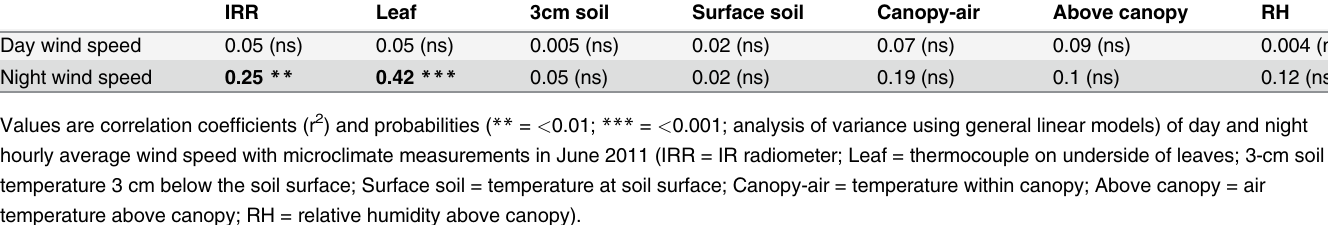
significant tank rental fees). Fig. 4 shows power consumption for one PHACE plot for summer and winter solstice of 2011. Power required to maintain the set temperatures varied greatly during single day and night periods. Periods of greatly changing power demand correspond with day/night warming targets and variable wind speed. Average daily power consumption for one plot was about 53 kWh in both summer and winter.